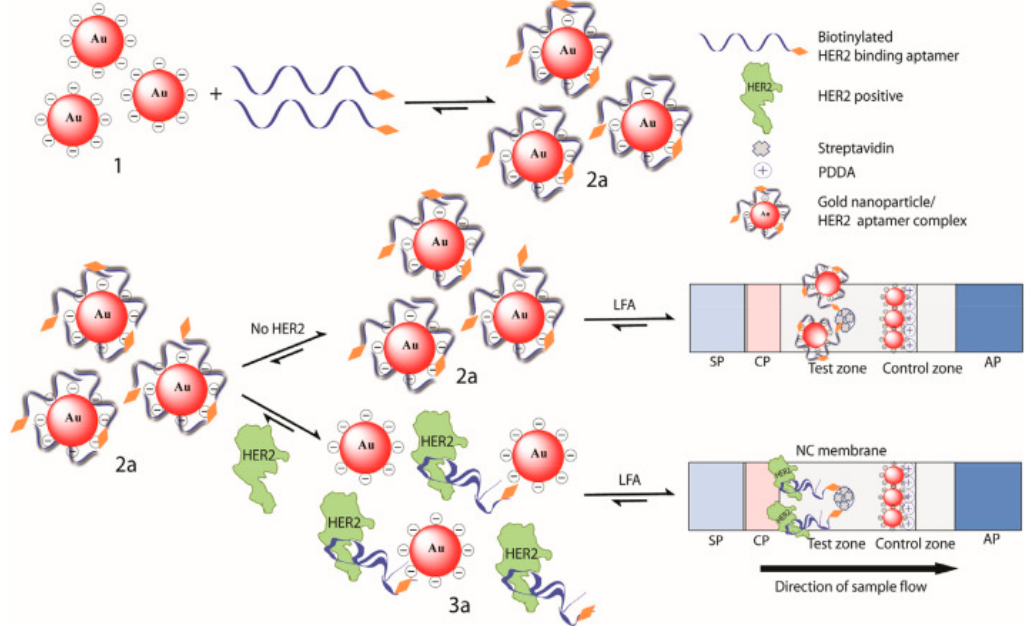
Figure 9. Scheme of HER2 detection by an adsorption-desorption colorimetric LFA. Reproduced with permission from [35].